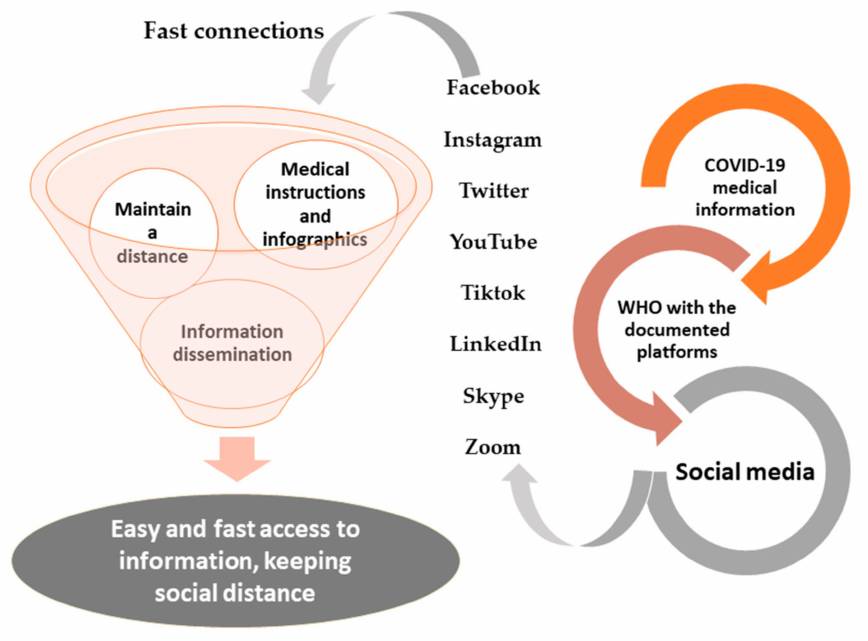
Figure 1. Social media participation and the continuation of its role during the pandemic, especially using documented pages of international and local organizations as well as press institutions on the Facebook and Twitter platforms to update information about COVID-19 around the clock for